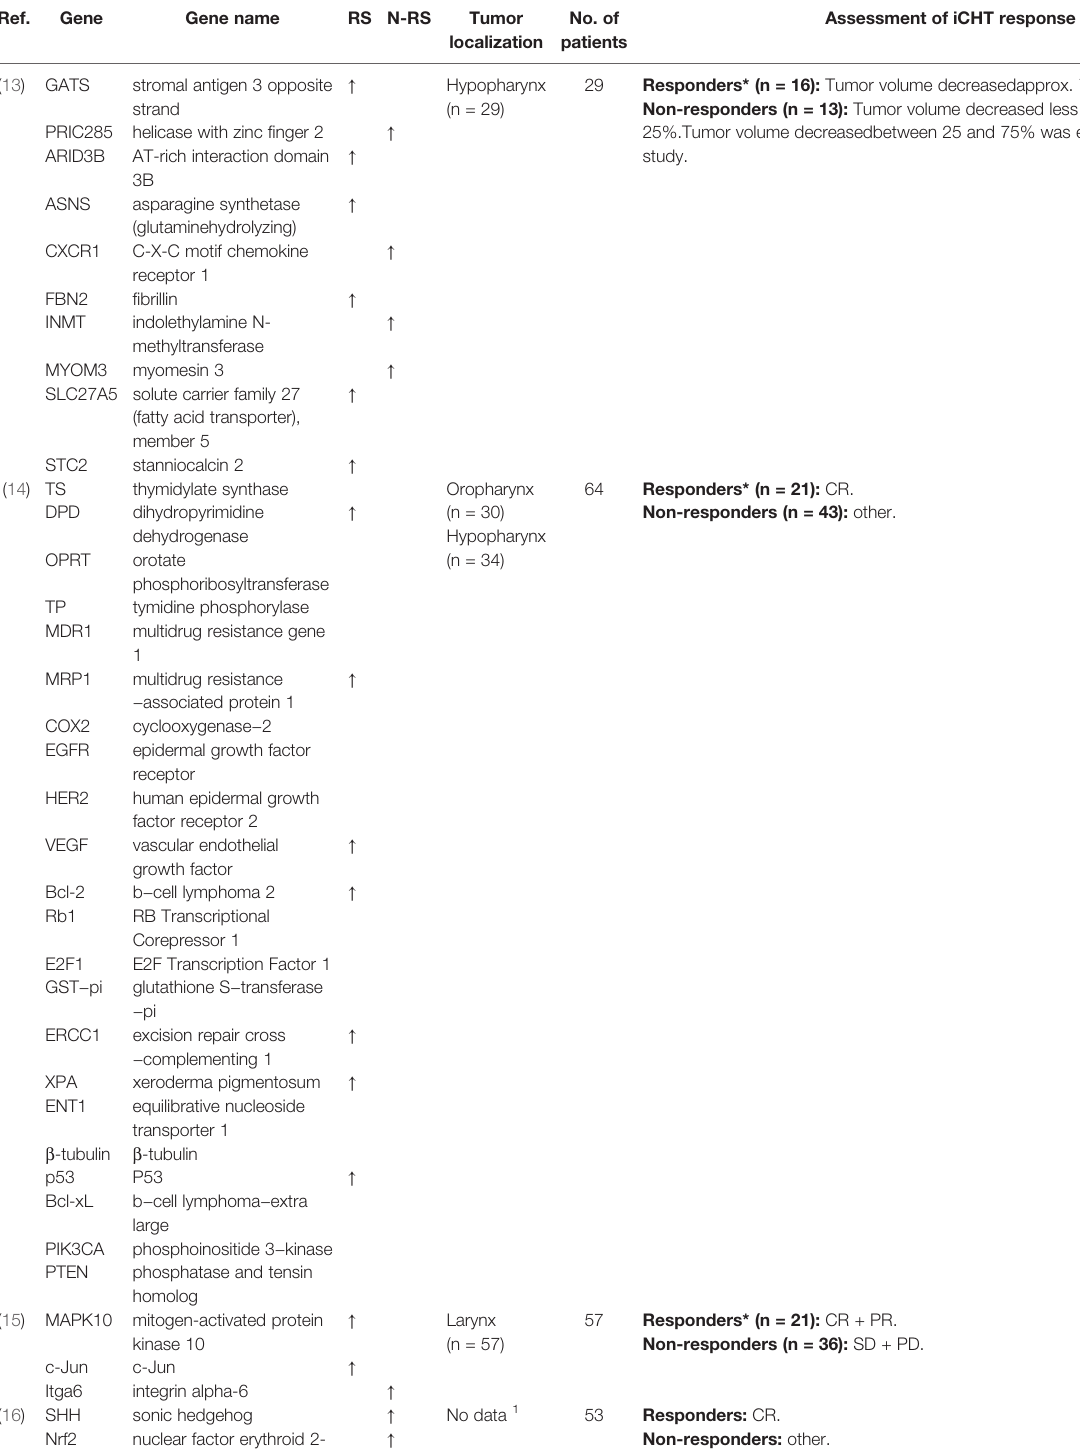
TABLE 1 | Summary of genetic studies on predicting iCHT response.